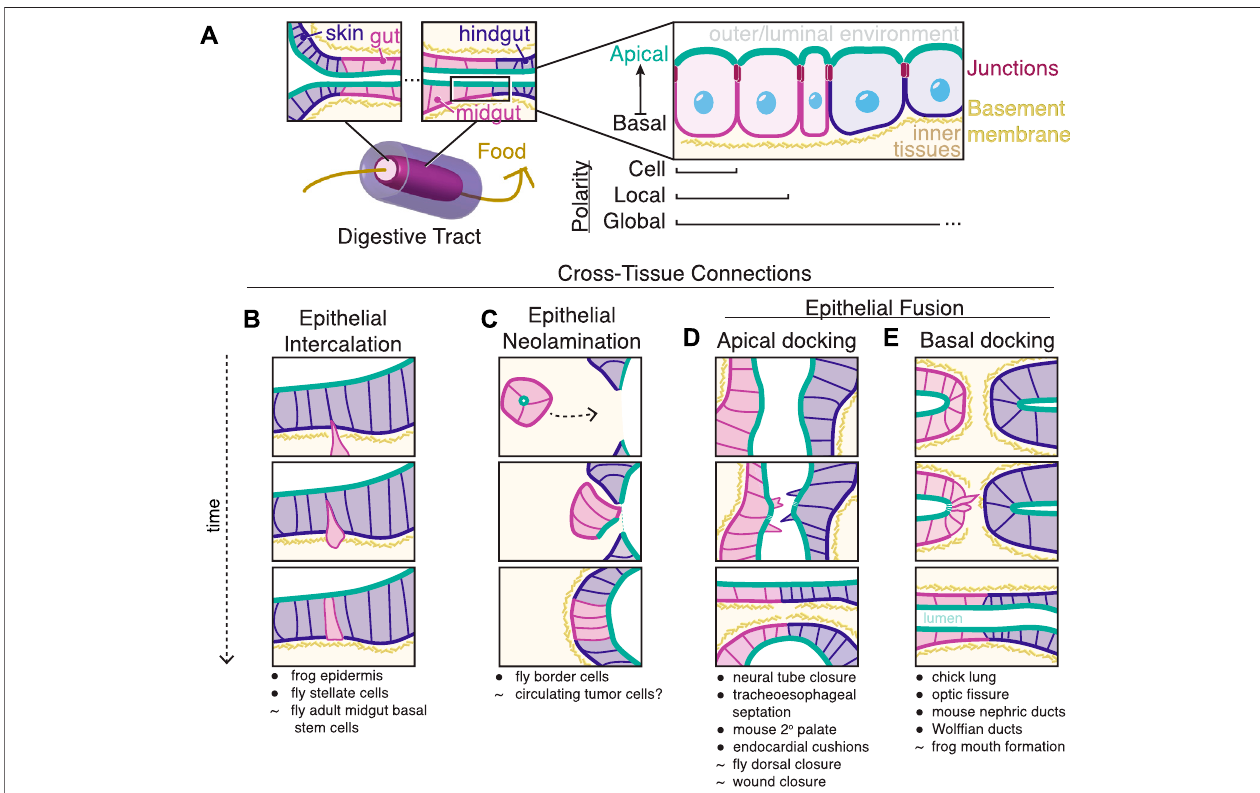
FIGURE 1 | Epithelial tissues connect during development. (A) A prominent example of epithelial fusion along an organ system is the digestive tract of the most common body plan of metazoans, a through gut. Outer skin epithelial cells (blue) meet internal gut epithelial cells (pink) at two ori fi ces. These epithelial cells are polarized along an apical (green) to basal axis separated by subapical junctions and lateral cell membranes. This polarity is aligned across multiple scales from individual cells to local groups of cells to global organ systems, including across neighboring tissues. (B – E) Simpli fi ed diagrams of mechanisms for creating cross-tissue connections.Ineachcase,epithelialneighborsofdifferentorigins(blueandpink)connecttocreatecontinuousapicalsurfaces(green). has overall similarity to the diagramed mechanism while ~ indicates related processes that we or others speculate may use similar mechanisms but where the tissue geometry is substantially different than what is shown in the diagrammed